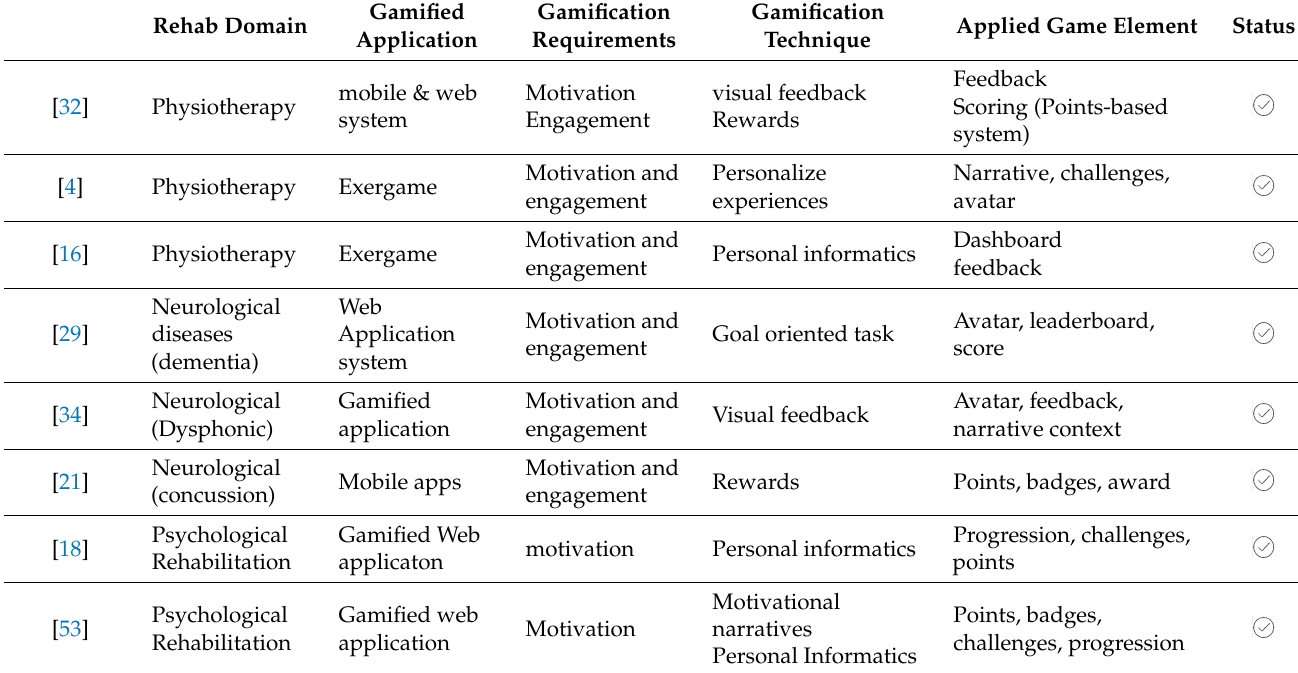
Table 3. Results of classification article